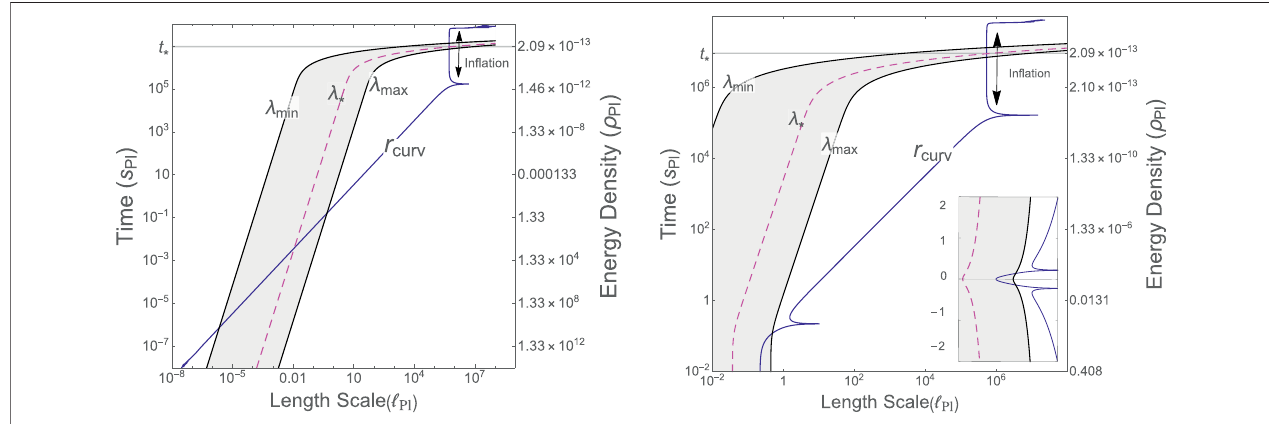
FIGURE3| Timedependenceofthe physical wavelengths λ (cid:1) a / k ofmodesandradiusofcurvature r curv inthepre-in fl ationaryera,usingStarobinskypotential.The left vertical axis shows cosmic time t (in Planck seconds) and right vertical axis shows the energy density (also in Planck units). The shaded bands represent the wavelengths of observable modes and the dashed line denotes the WMAP pivot mode with λ + (cid:1) a ( t ) / k + . The solid (blue) lines represent the evolution of r curv . Left panel: GeneralRelativity. In thePlanck regime near singularity ( t (cid:1) 0), all observablemodes exit thecurvature radius and are thus excited. Rightpanel: LQC. Only the longest wavelength modes in the observable band get excited and fail to be in the BD vacuum at t (cid:1) t + . The inset shows dynamics near the bounce. Plots of the quadratic potential are very similar.